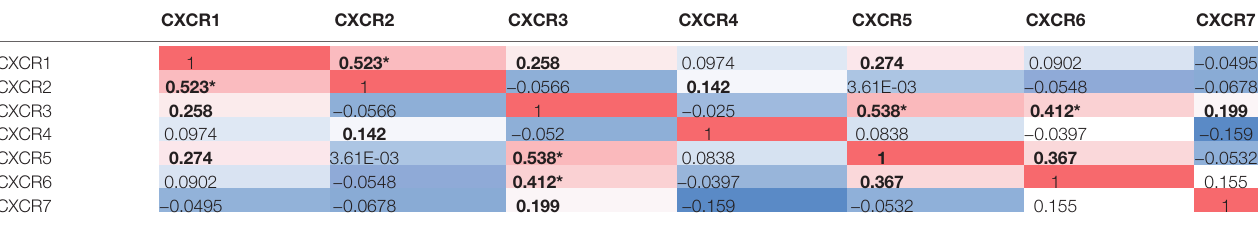
TABLE 4 | The correlations of CXCRs with each other in AML (RNA Seq V2 RSEM).